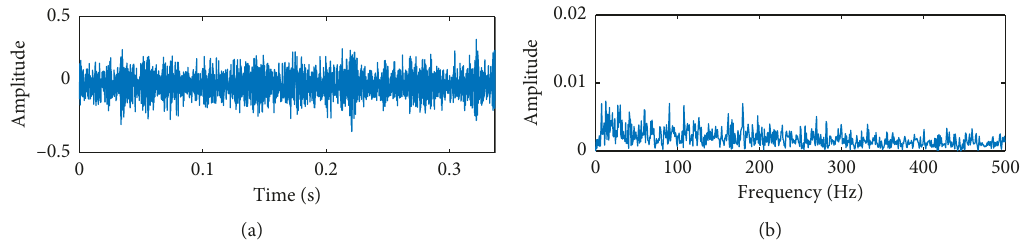
Figure 10: The single fault experimental signal: (a) TW; (b)